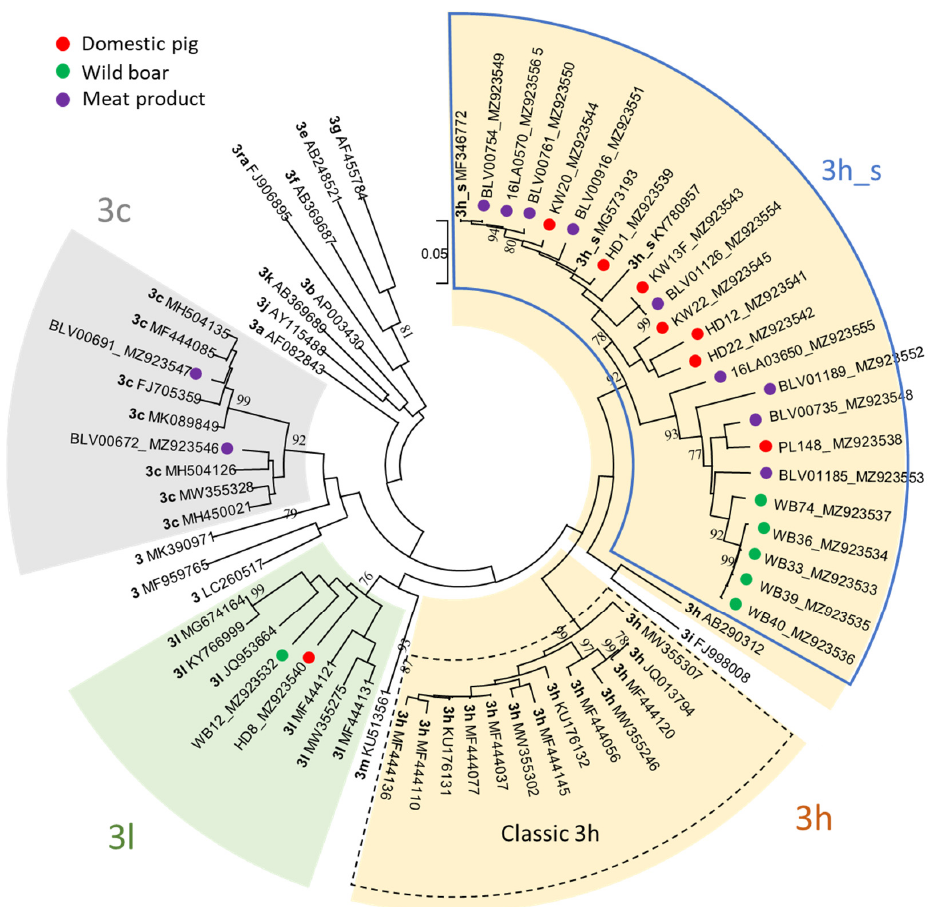
Figure 3. Phylogenetic tree of a 493 nt long fragment of the ORF2 including the 26 sequences resulting from this study (colored dots; accession numbers provided after sequence name) and 42 previously assigned HEV-3 reference genomes [39,41]. The evolutionary history was inferred by using the Maximum Likelihood method and Tamura-Nei model [42]. The tree with the highest log likelihood from 1000 bootstrap replicates is shown. The tree is drawn to scale, with branch lengths measured in the number of substitutions per site. Bootstrap values above 75% are shown. For the subtypes 3h and 3l all previously assigned genomes, for 3c a selection of six assigned genomes and for all other subtypes the single representative reference genomes as previously suggested [41] were included.